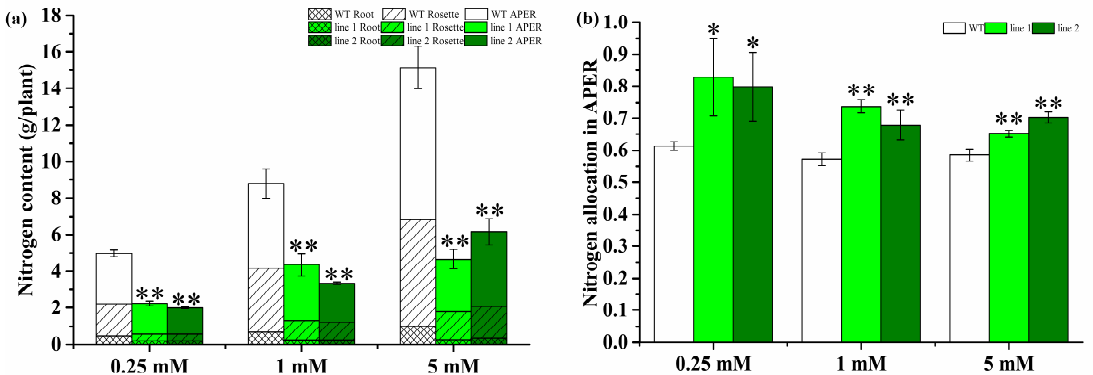
Figure 8. Analysis of N content and allocation in overexpression Arabidopsis (OE) and wild type (WT). ( a ) The N composition in OE lines and WT. ( b ) The N allocation in aerial part excluding rosette (APER). 0.25 mM N, 0.125 mM NH 4 NO 3 ; 1 mM N, 0.50 mM NH 4 NO 3 ; 5 mM N, 2.50 mM NH 4 NO 3 . Values are means ± standard (SD) ( n = 4). Asterisks indicate significant difference between WT and two OE lines (line 1, line 2). * p < 0.05; ** p < 0.01 ( t -test).